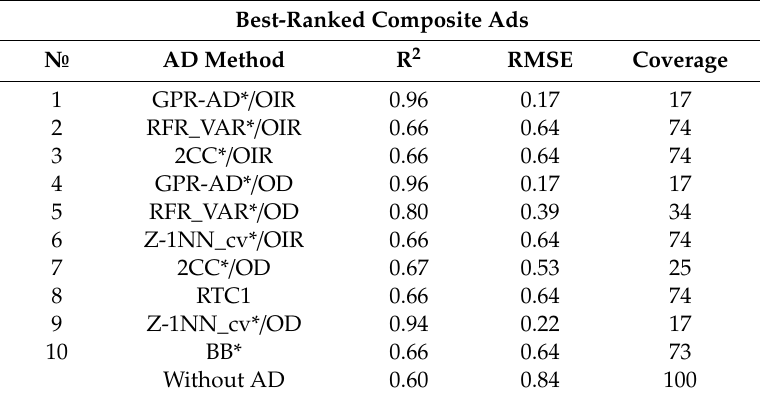
Table 5. Coe ffi cient of determination (R 2 ) and RMSE of prediction for the external test set (only reactions within AD are